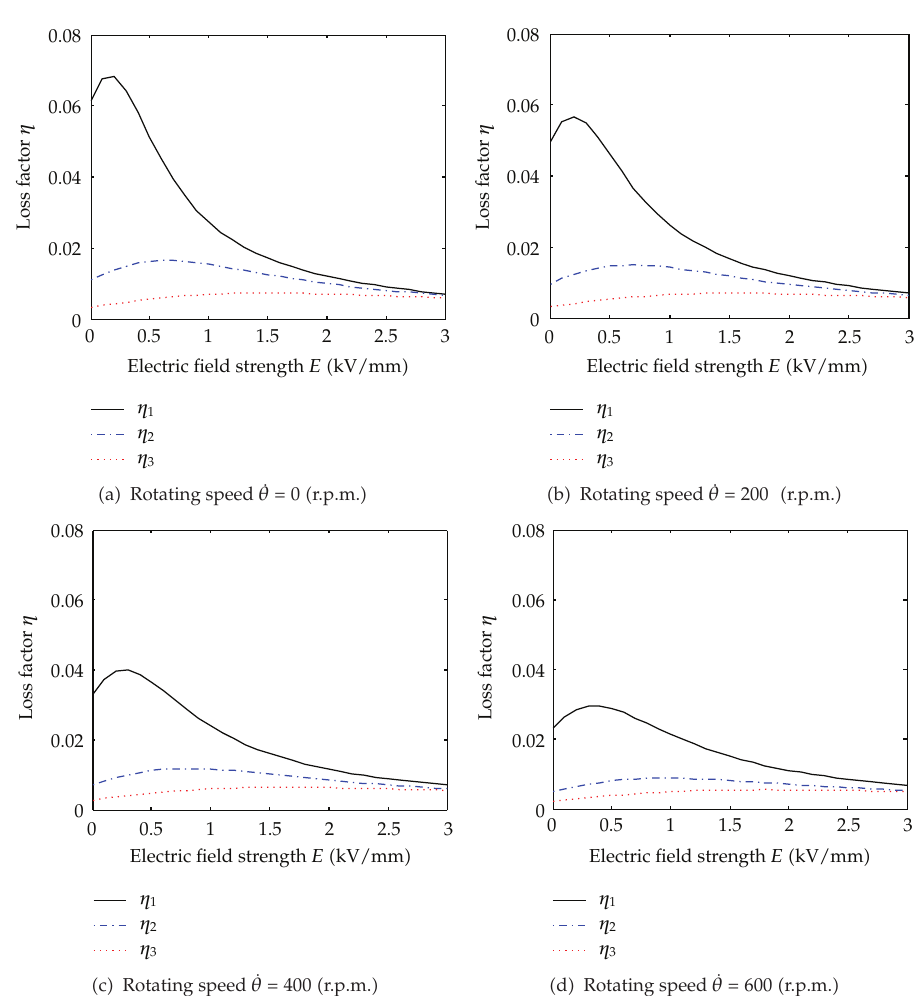
Figure 6: E ff ect of strength of electric field on the first three loss factors at di ff erent rotation